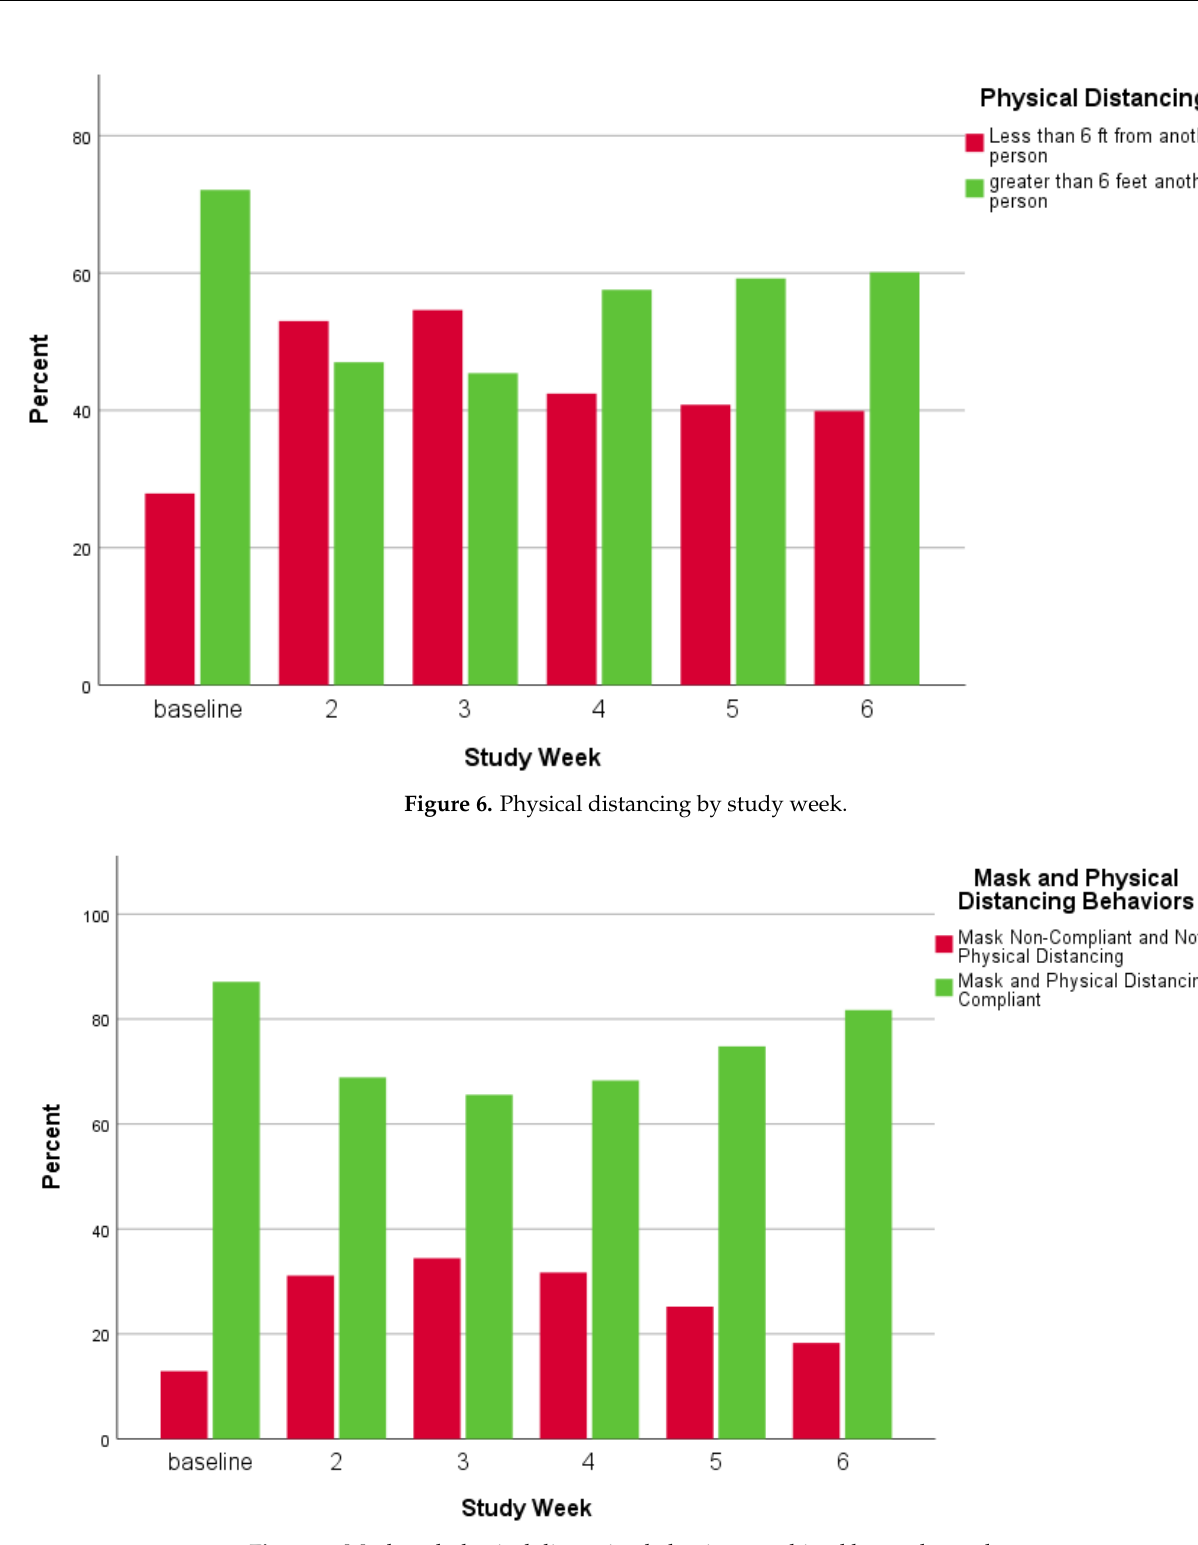
Figure 5. Mask wearing compliance by study week.